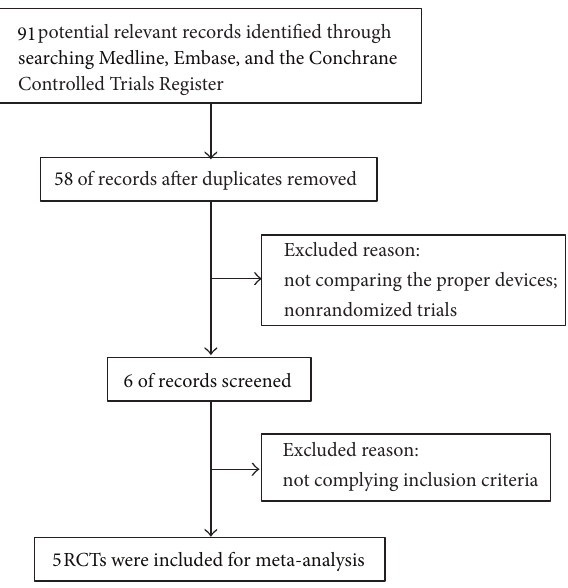
Figure 1: Study flow diagram.